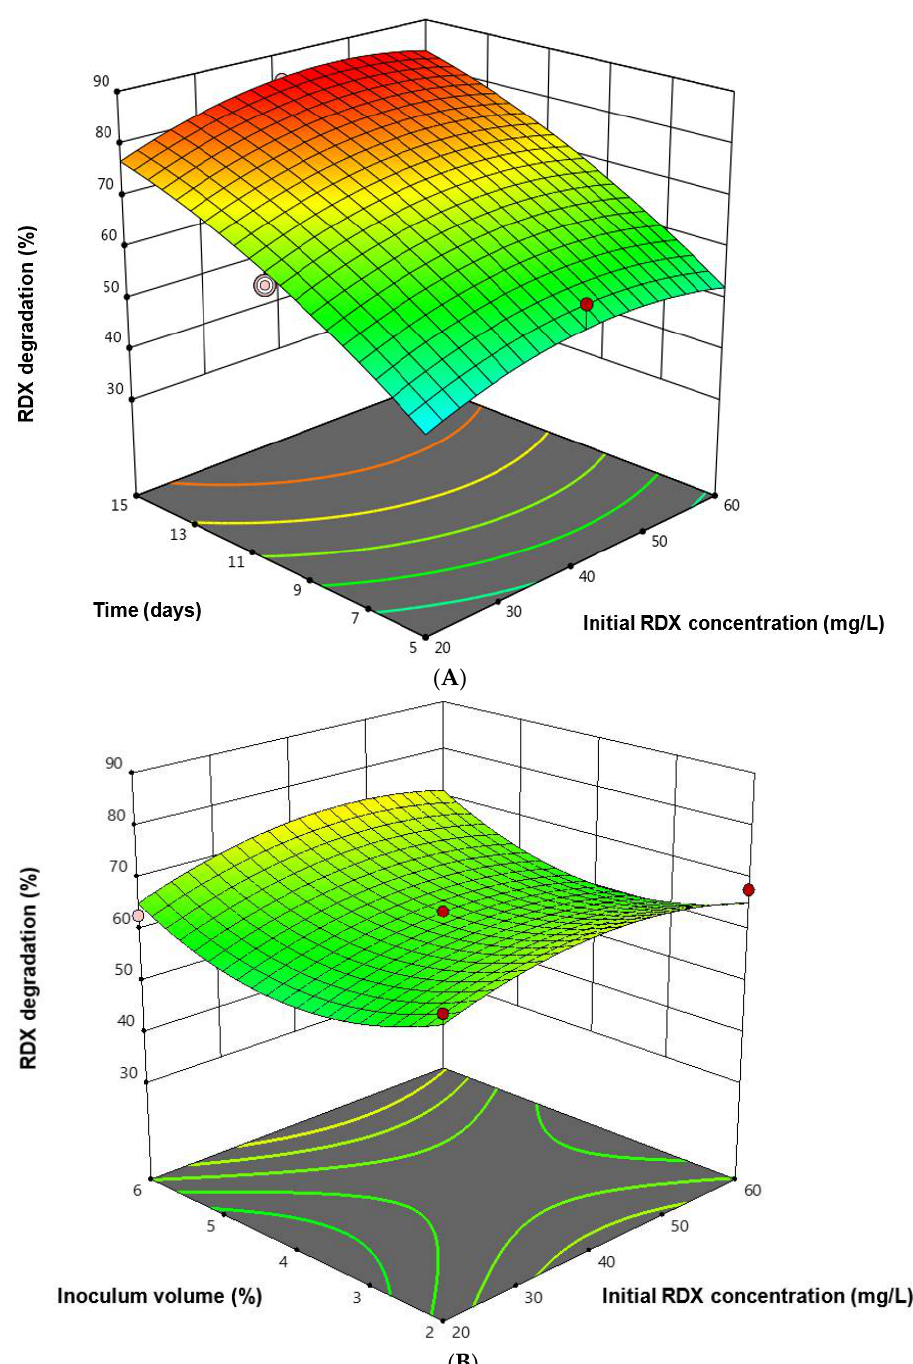
Figure 3. ( A ) 3-D model plot for the degradation of RDX under varying initial concentration (mg/L) and time (days) with Paenibacillus dendritiformis. ( B ) 3-D model plot for the degradation of RDX under varying initial concentration (mg/L) and inoculum volume (%) with Paenibacillus dendritiformis . Table 3. ANOVA of Quadratic model for percent degradation of RDX with Paenibacillus den-